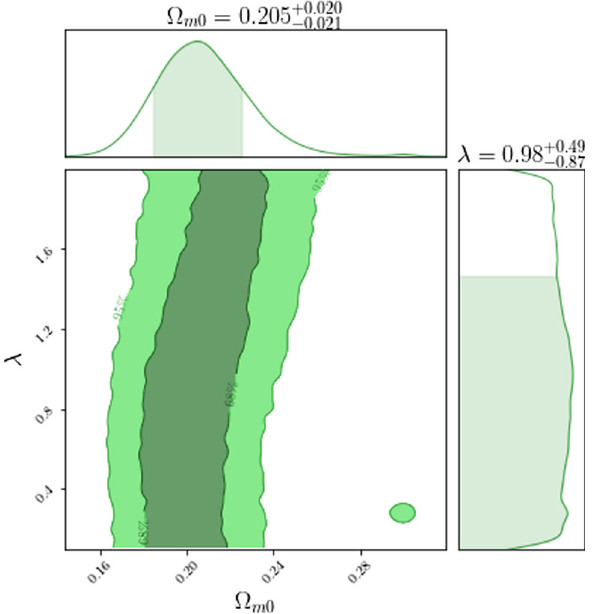
Fig. 6 MCMC simulations for the f ( R ) model with n = 2, consider- ing H ( z ) data and the flat priors: λ − 1 ∈ [ 0 . 1 , 2 ] and Ω m 0 ∈ [ 0 . 15 , 0 . 4 ]